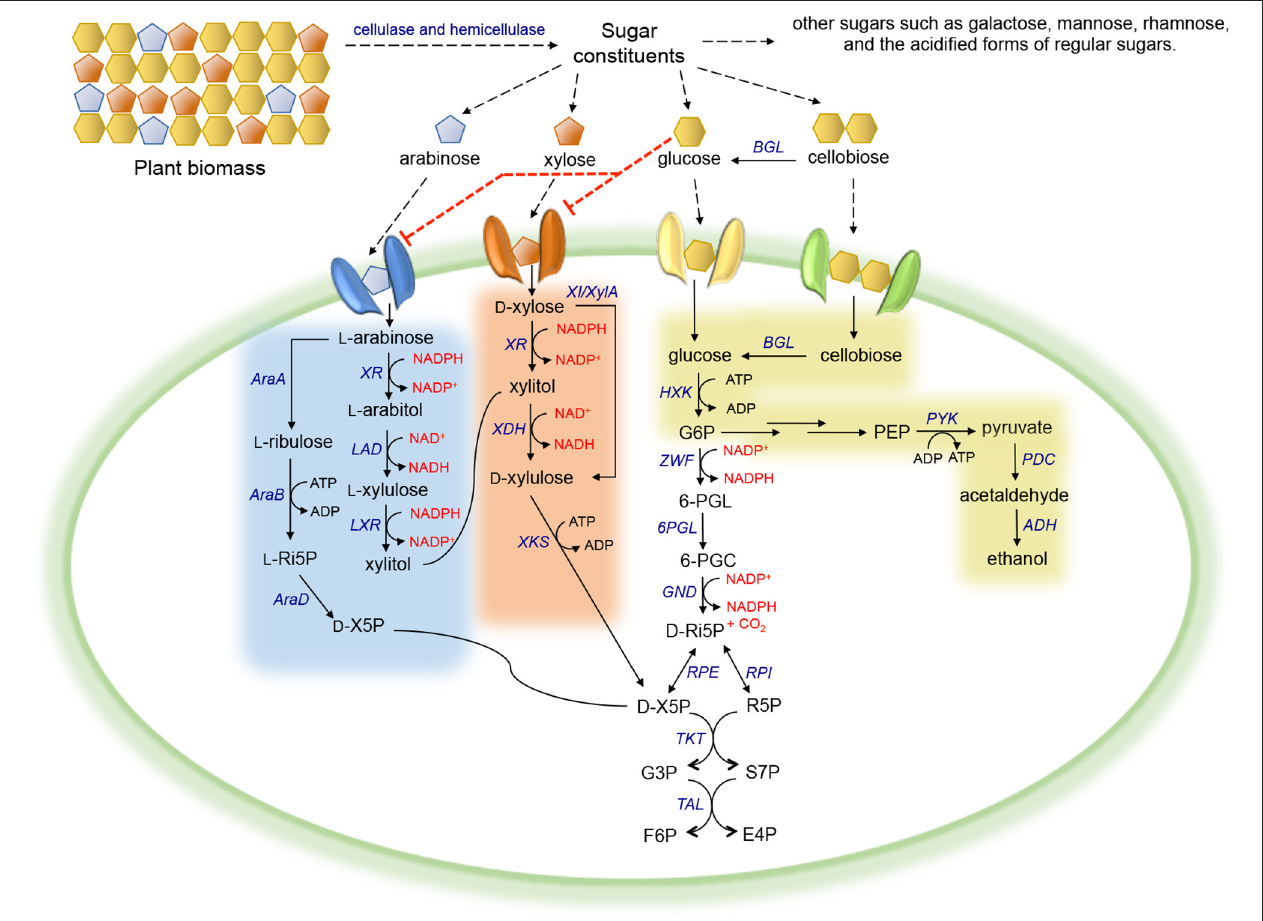
FIGURE 1 | Carbohydrate metabolism in microorganisms. Red dotted line corresponds to inhibition. Abbreviation of metabolites—PEP, phosphoenolpyruvate; G6P, glucose-6-phosphate; 6-PGL, 6-phosphogluconolactone; 6-PGC, 6-phosphogluconate; D-Ri5P, D-ribulose-5-phosphate; D-X5P, D-xylulose-5-phosphate; R5P, ribose-5-phosphate; G3P, glyceraldehyde-3-phosphate; S7P, sedoheptulose-7-phosphate; F6P, fructose-6-phosphate; E4P, erythrose-4-phosphate; L-Ri5P, L-ribulose-5-phosphate. Abbreviation of enzymes—BGL, β -glucosidase; HXK, hexokinase; PYK, pyruvate kinase; PDC, pyruvate decarboxylase; ADH, alcohol dehydrogenase; ZWF, glucose-6-phosphate dehydrogenase; 6PGL, 6-phosphogluconolactonase; GND, 6-phosphogluconate dehydrogenase; RPI, ribose-5-phosphate isomerase; RPE, ribulose-5-phosphate epimerase; TKT, transketolase; TAL, transaldolase; XR, xylose reductase; XDH, xylose dehydrogenase; XKS, xylulokinase; XI/XylA, xylose isomerase; LAD, L-arabitol 4-dehydrogenase; LXR, L-xylulose reductase; AraA, L-arabinose isomerase; AraB, L-ribulokinase; AraD, L-ribulose-5-phosphate